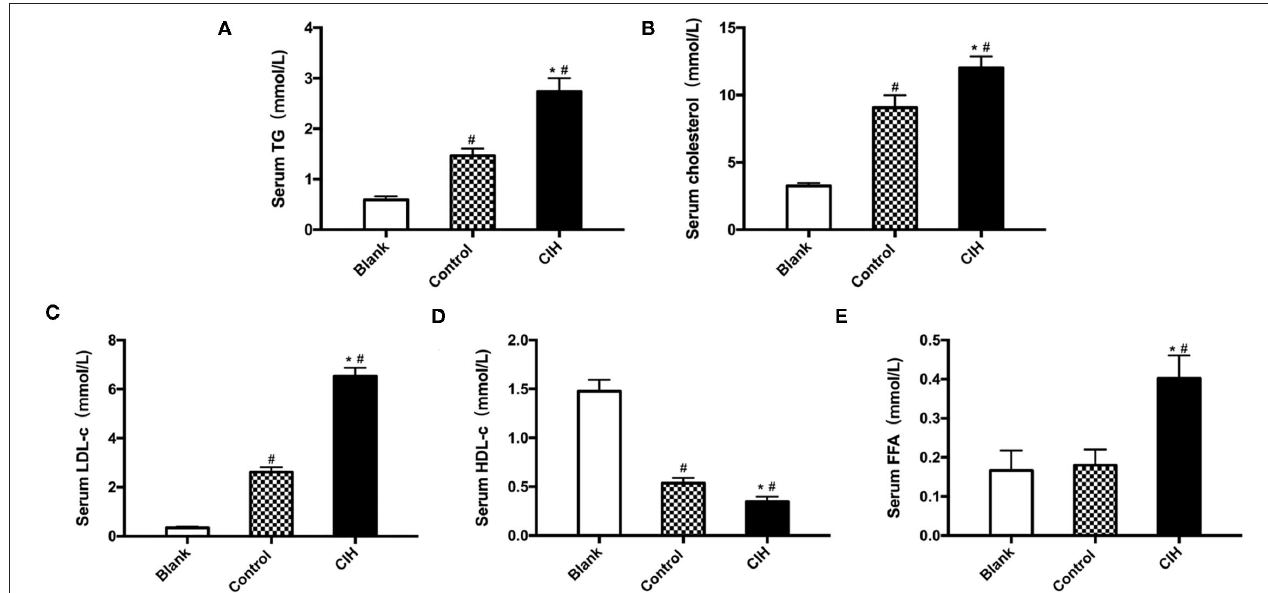
FIGURE 3 | Hyperlipidemia and lipolysis induced by CIH. Male wild-type C57BL/6J mice as Blank group. Male ApoE − / − mice exposed to normoxia or CIH grouped as control and CIH group. (A) TG levels in the serum of mice. (B) TC levels in the serum of mice. (C) LDL-c levels in the serum of mice. (D) HDL-c levels in the serum of mice. (E) FFA levels in the serum of mice. n = 6. Data were presented as mean ± SEM. * CIH vs. control p < 0.05. # vs. Blank p <